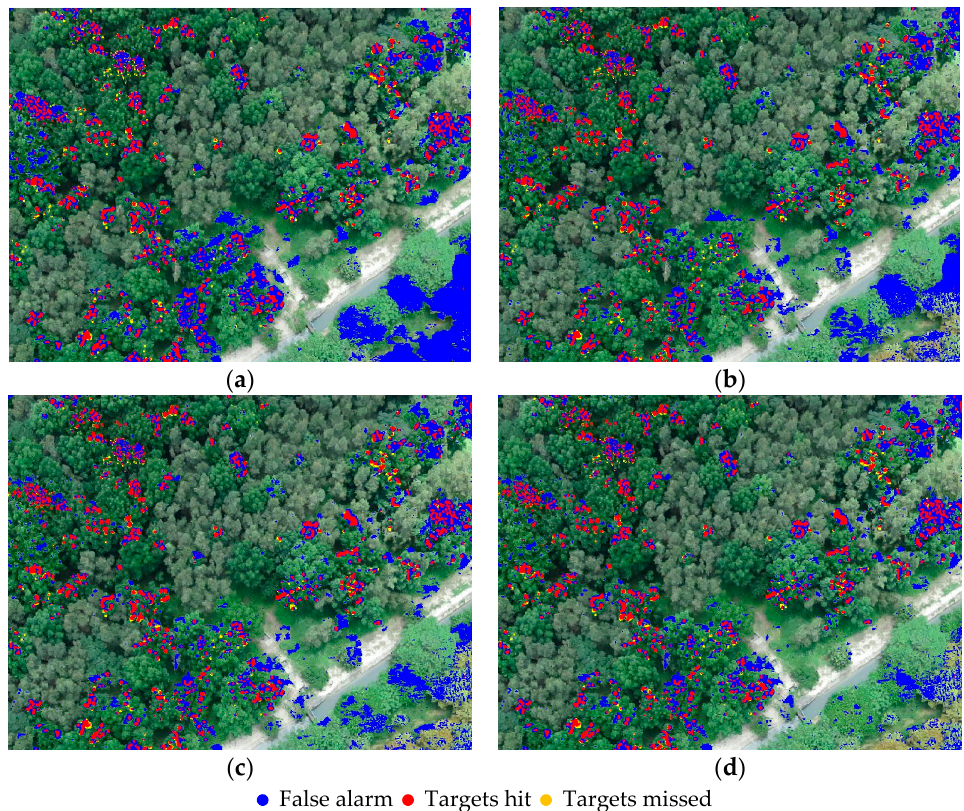
Figure 17. Detection results highlighted with different colors of 4 algorithms in Region 2. ( a ) CEM ( b ) Subset CEM ( c ) Sliding Window-based CEM (SW CEM) ( d ) Adaptive Window-based CEM (ASW CEM).